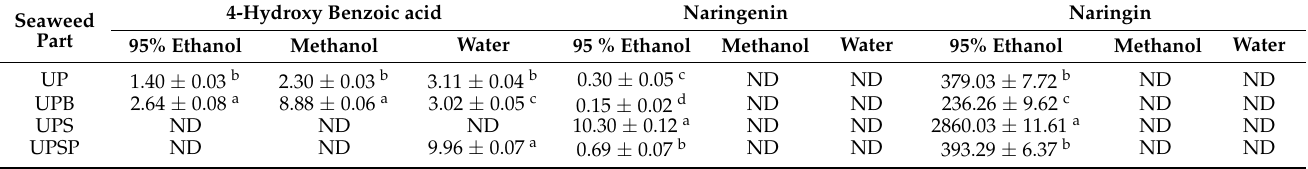
Table 5. Phenolic compound content ( µ g/g) of different parts of Undaria pinnatifida . 4-Hydroxy Benzoic acid Naringenin Naringin Seaweed Part 95% Ethanol Methanol Water 95 % Ethanol Methanol Water 95% Ethanol Methanol Water